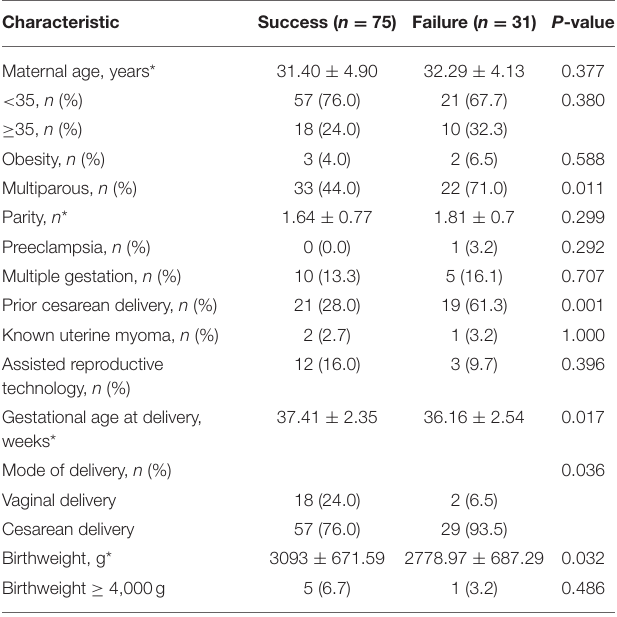
TABLE 1 | General and obstetric characteristics of the study population. TABLE 2 | PPH characteristics.